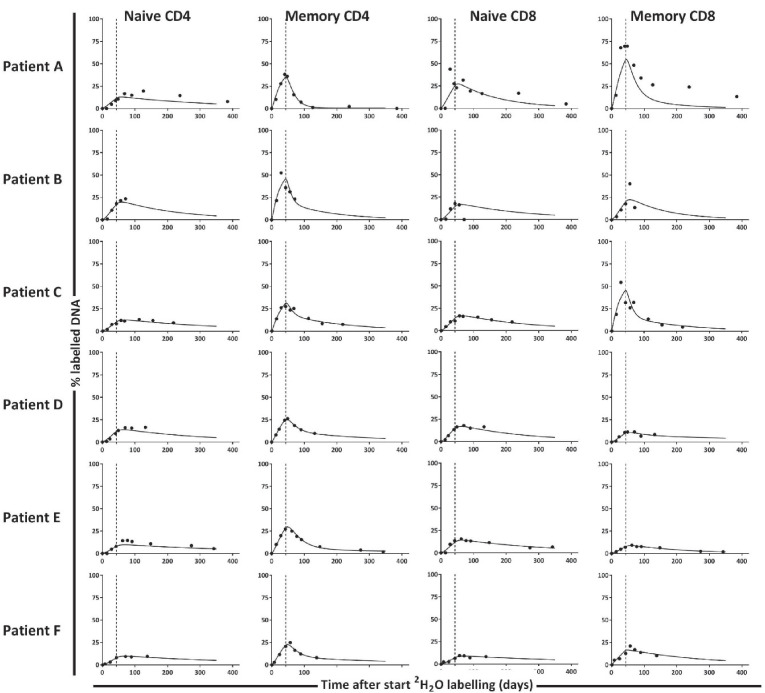
Best fits of 2H enrichment in T-cell subsets in autologous hematopoietic stem cell transplantation (autoHSCT) patients.Best ﬁts of the model (see Materials and methods) to the enrichment data in naive and memory CD4+ and CD8+ T-cells in the six autoHSCT patients (A–F). Measured enrichments are shown by black dots. Label enrichment in the DNA was scaled between 0% and 100% by normalizing for the maximum enrichment in granulocytes (see Materials and methods). The end of 2H2O administration is marked by a dashed vertical line. Best fits of 2H enrichment of the corresponding subsets in healthy individuals were previously published by Westera et al., 2015.